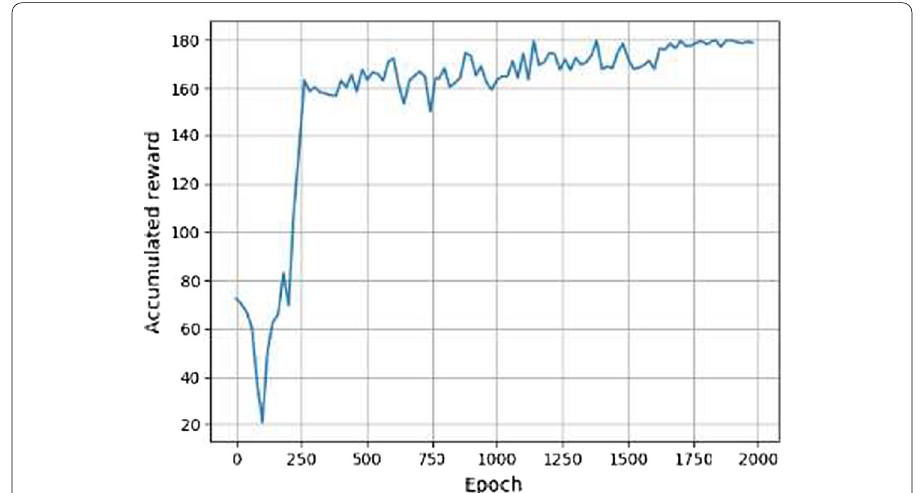
Fig. 5 Learning curve of DDQN